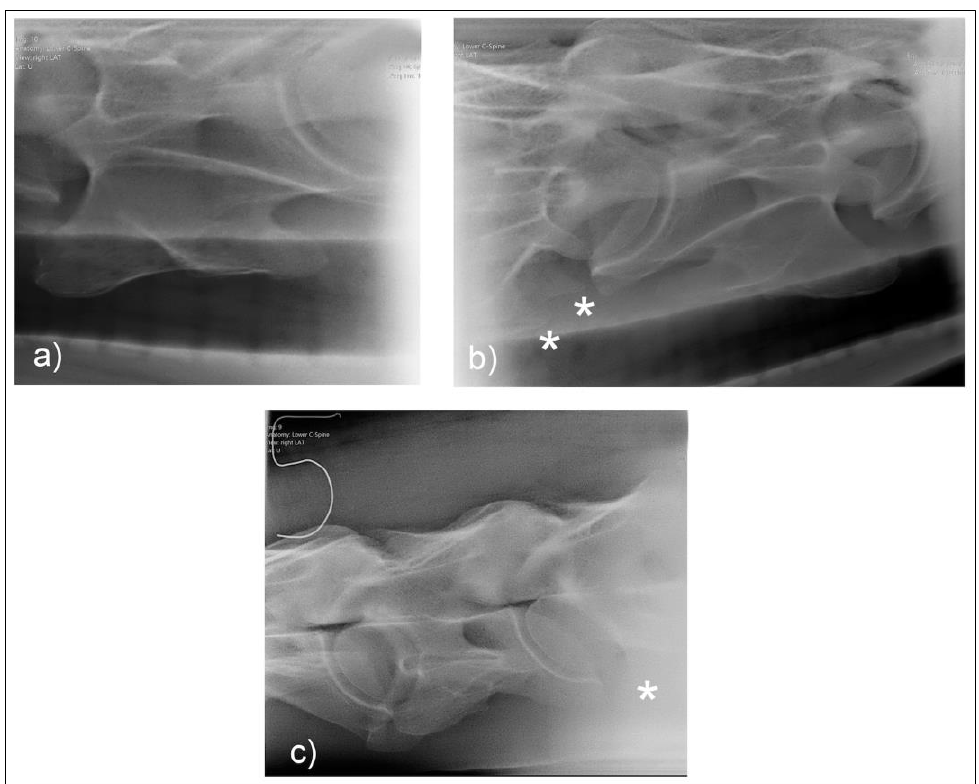
Figure 9. The radiographic images of the 30° dorsal to ventral oblique left ( a ) and right ( b ) of C6 in horse M2 and the laterolateral view ( c ) of horse M2 with bilateral morphologic variation of C6 and transposition on to C7 (*). (Note example of marker dorsal to C5 transverse process).